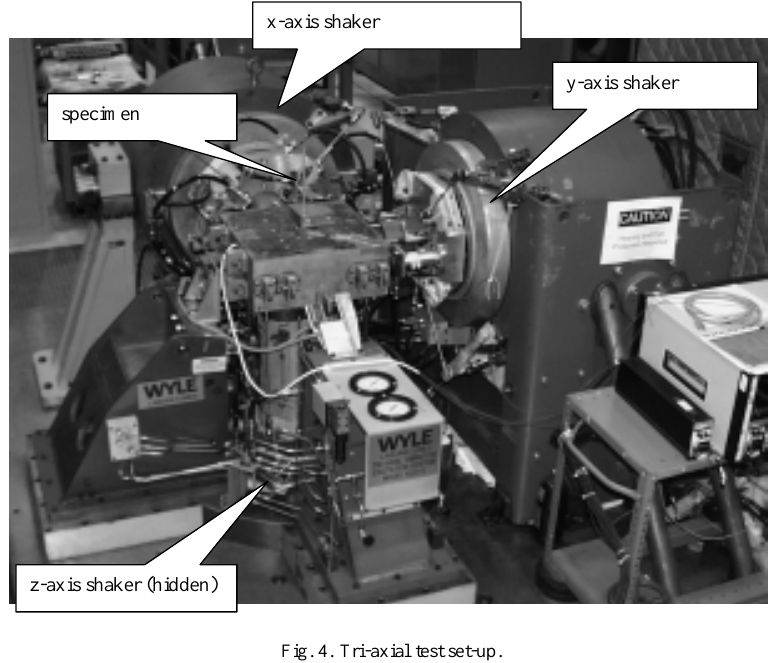
Fig. 4. Tri-axial test set-up.